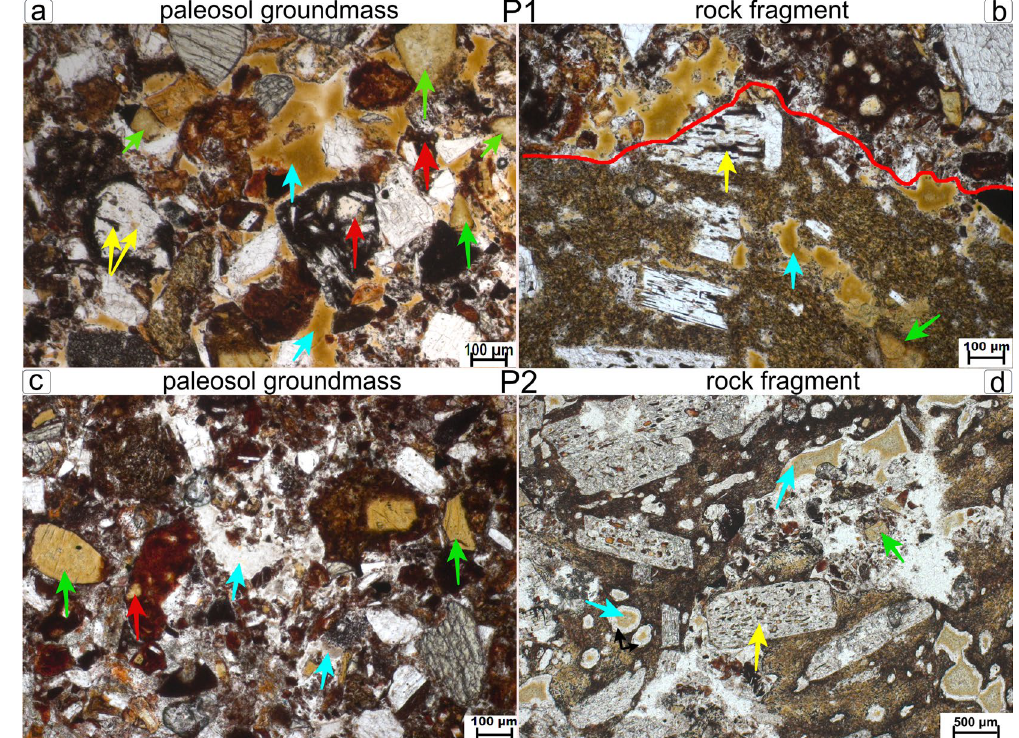
Figure 3. Alterations types occurring in the groundmass of paleosols and in rock fragments under plane polarized light (PPL). ( a ) P1-Bwb2, 23–34 cm: brown infillings (blue arrows); clay filling vesicles in glass shards (red arrows); brownish clays of former olivines (green arrows); yellow arrows: alterations of plagioclase ( b ) P1-Bwb2, 23–34 cm: similar alterations occurring inside a rock fragment, the red line defines the limit between rock (below the line) and paleosol (above the line). ( c ) P2-Bwb1, 20–30 cm: grey infillings are almost transparent under PPL (blue arrows); clay (red arrow) filling vesicles in glass shards; brownish clays in former olivine (green arrows). ( d ) P2-Bwb1, 20–30 cm: same alterations occurring in a rock fragment; note the brown infilling (blue arrow) surrounded by a white rim due to Fe depletion (black arrows); alteration of plagioclase (yellow